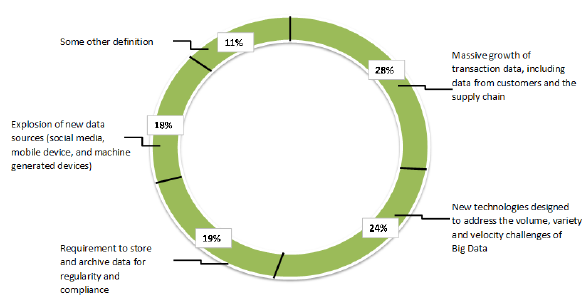
Figure 2: Definitions of Big Data based on an online survey of 154 global executives in April 2012